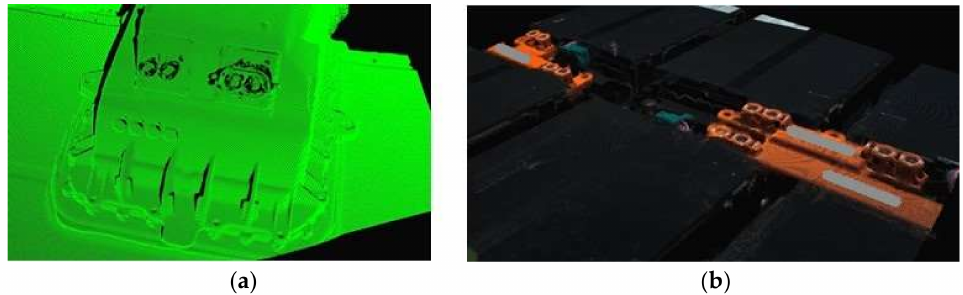
Figure 8. Point cloud of the switch box ( a ), modules and busbars ( b ) that were captured with Zivid Two.